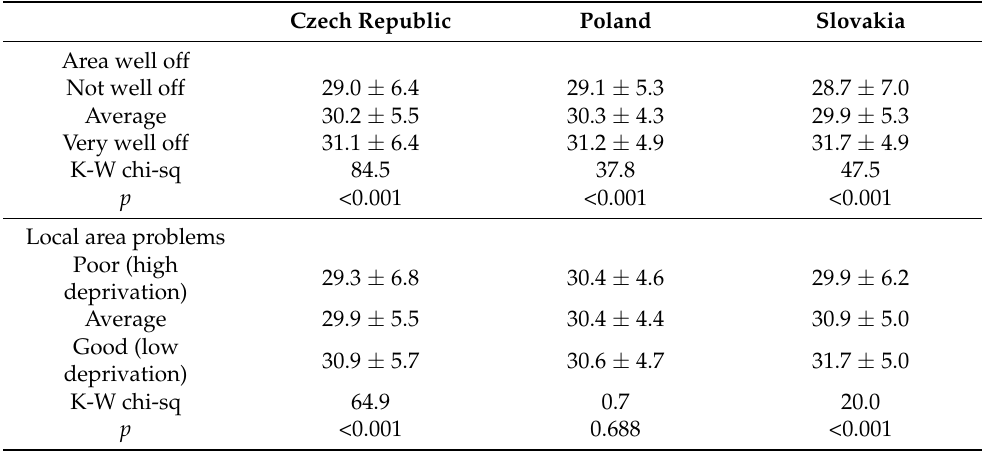
Table 4. Mean health literacy by neighbourhood structural